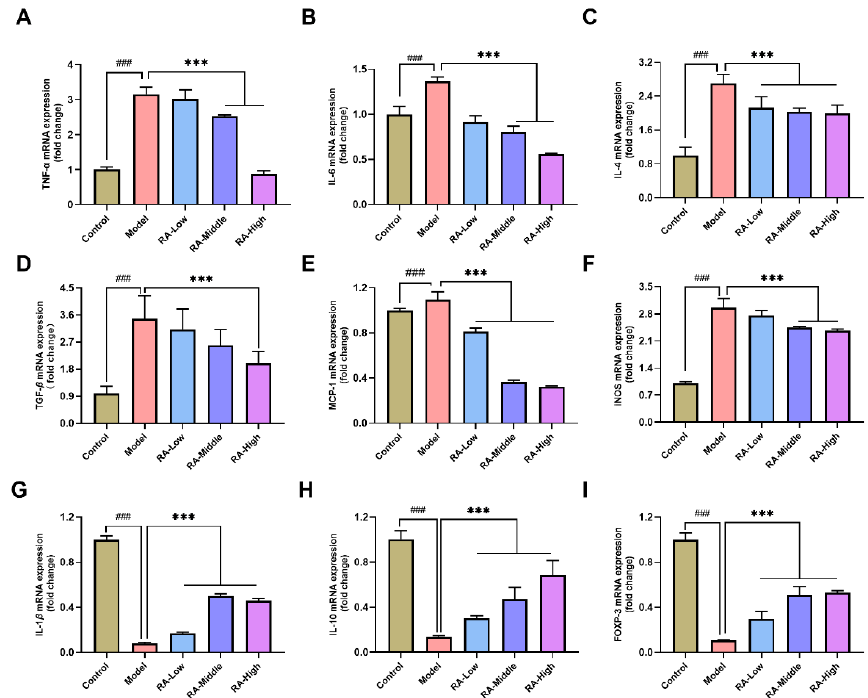
Figure 5. Effects of RA on the expression of cytokines on the liver of OVA-induced allergic mice. The mRNA expression fold changes of cytokines (TNF- α ( A ), IL-6 ( B ), IL-4 ( C ), TGF- β ( D ), MCP-1 ( E ), iNOS ( F ), IL-1 β ( G ), IL-10 ( H ) and FOXP-3 ( I )) were analyzed by real-time fluorescent quantitative PCR. ### p < 0.01 compared with the PBS group; *** p < 0.01 compared with the OVA-allergic model group.